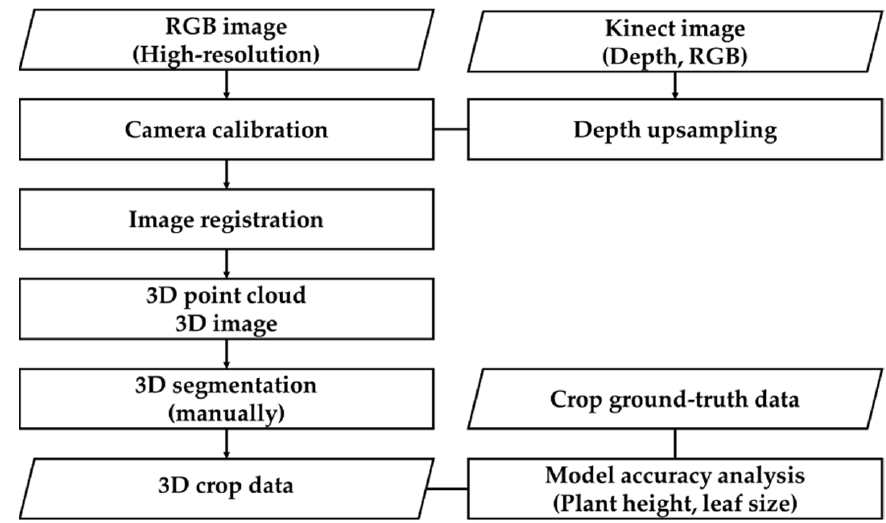
Figure 3. Flowchart for image acquisition, 3D reconstruction, and analysis.